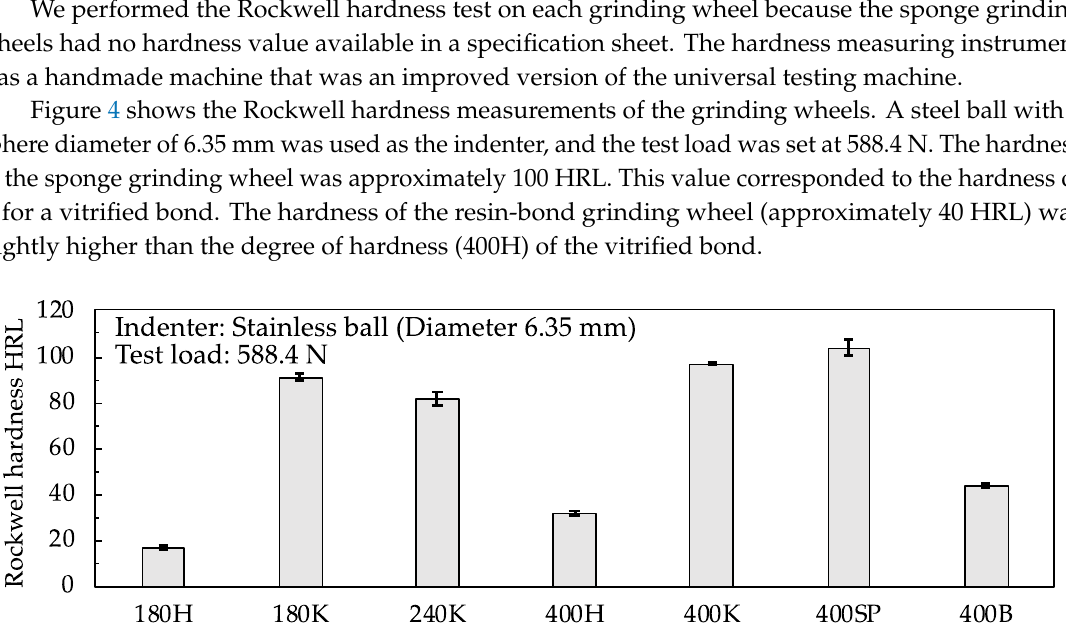
Table 1. Wheels used in the grinding.